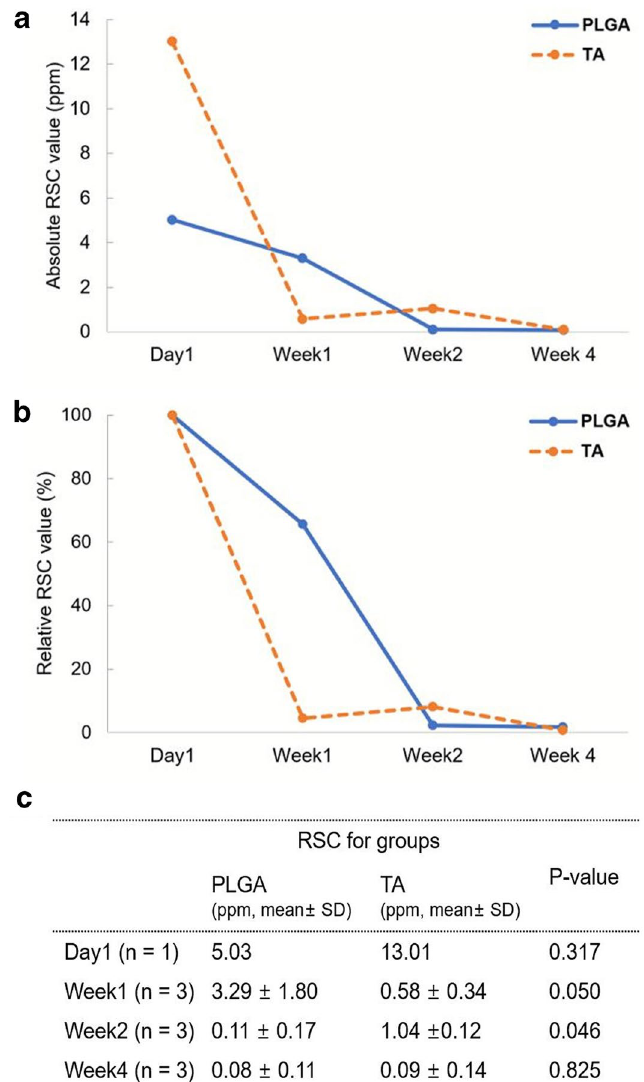
Figure 6. Trend of RSC over time in the injection segment of each group. The RSC trends over time was investigated using mean ± standard deviation of each group and time-point. The RSC were presented as absolute RSC value ( a ) and relative RSC value ( b ) expressing as a percentage of the RSC recorded on day 1 of each group. Steroid-loaded PLGA showed a tendency of slow degradation during the initial period. ( c ) P -value obtained from generalized estimating equations employed to investigate whether the interaction between time and the formulation affects the RSC